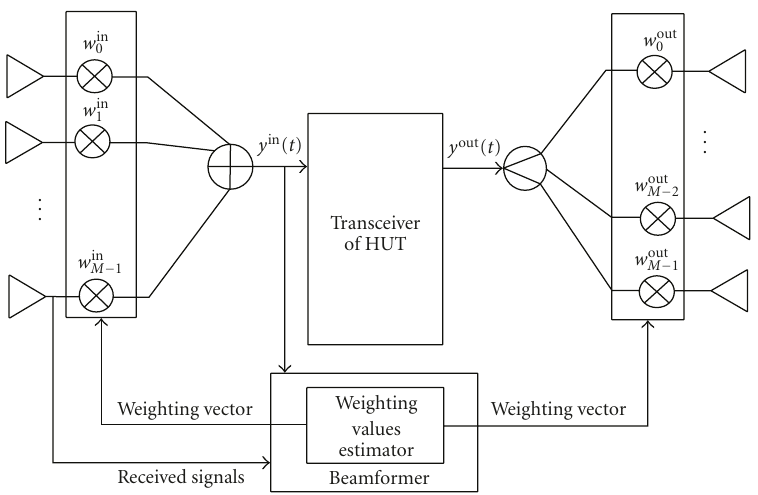
Figure 10: Block diagram for the HUT using ABS.